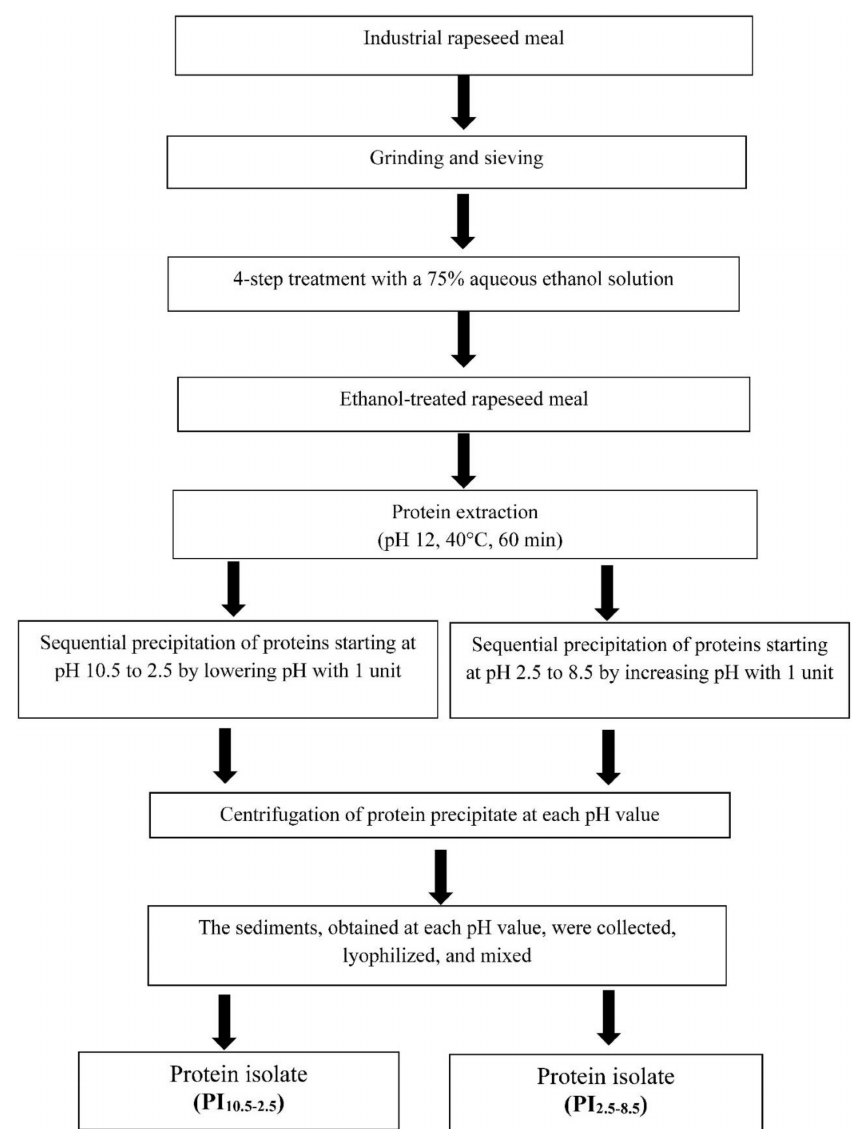
Figure 1. Preparation of protein isolates, PI 2.5–8.5 and PI 10.5–2.5 , from ethanol-treated rapeseed